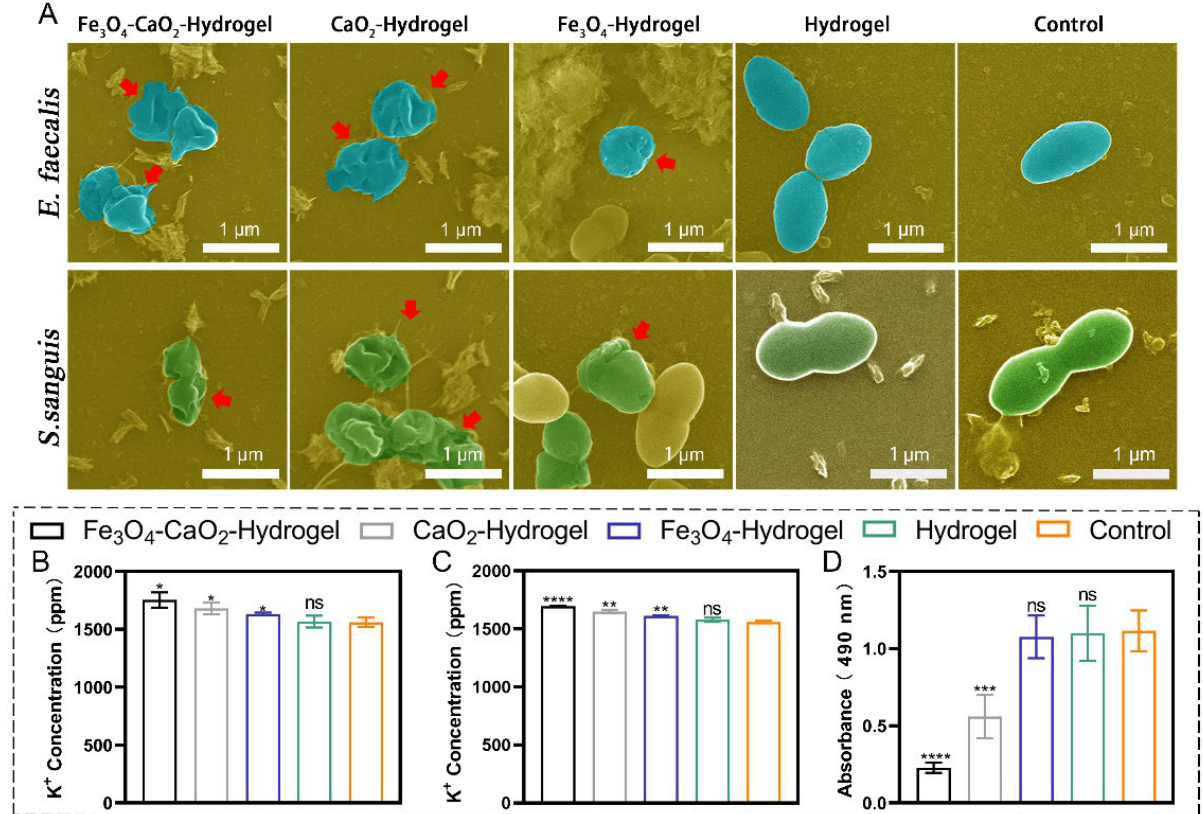
Figure 4. Antibacterial mechanism of Fe 3 O 4 -CaO 2 -Hydrogel. ( A ) SEM observation, red arrows show apparent damage and deformation of bacteria. ICP assay of ( B ) E. faecalis and ( C ) S. sanguis . ( D ) EPS production after co-culture of bacterial biofilms with each group of samples. * p < 0.05, ** p < 0.01, *** p < 0.001, **** p < 0.0001. ns, not significant.